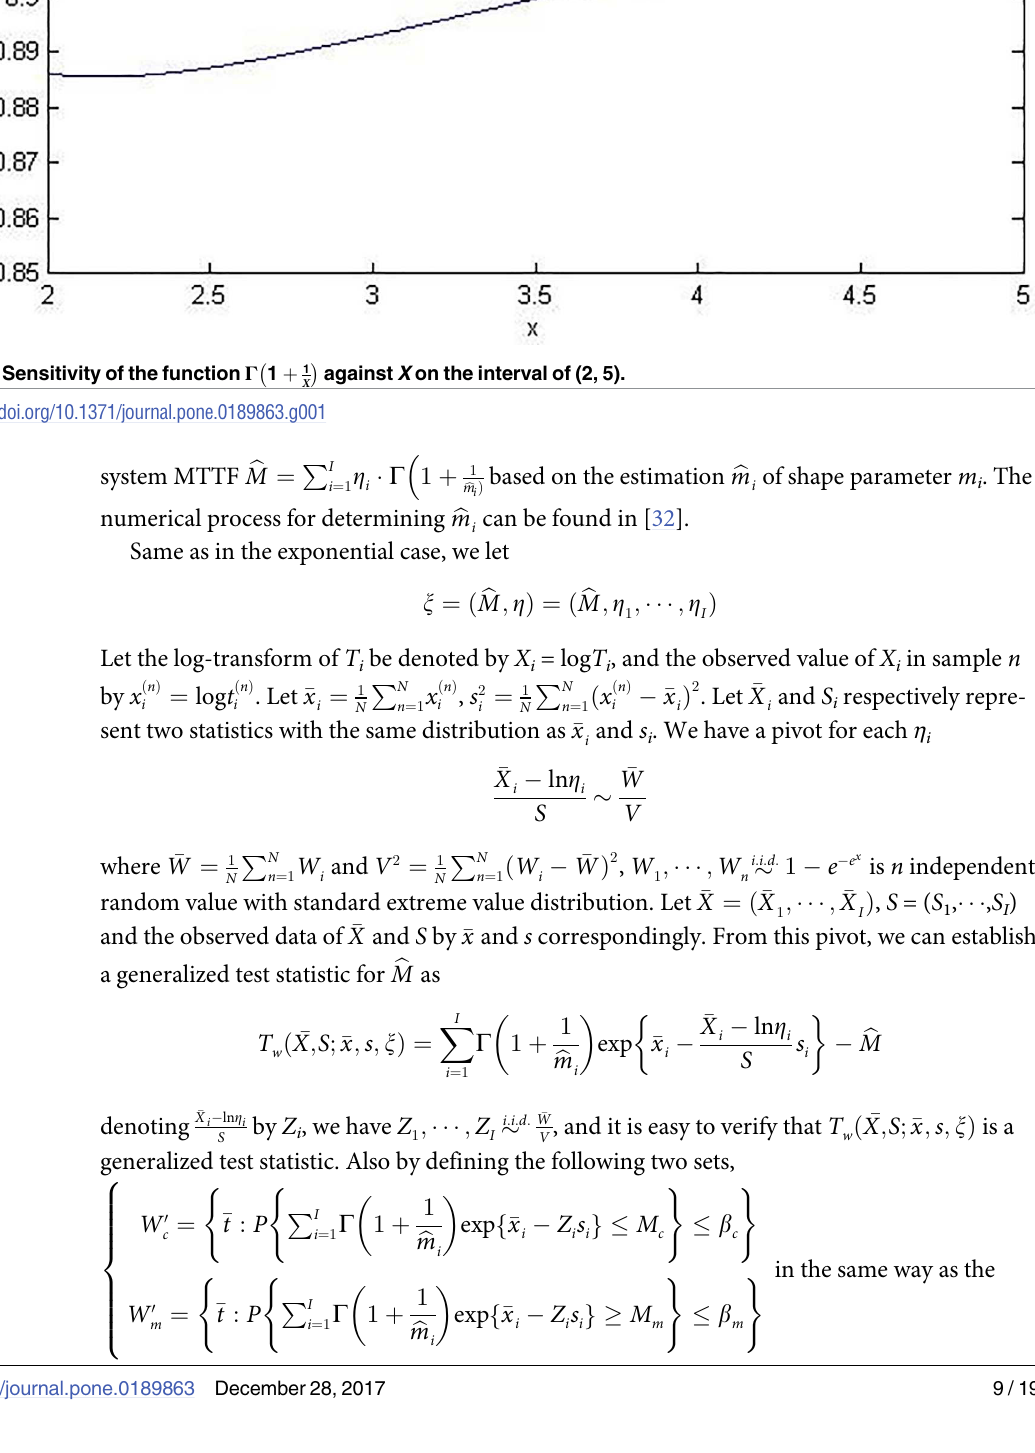
Fig 1. Sensitivity of the function Γ 1 þ 1